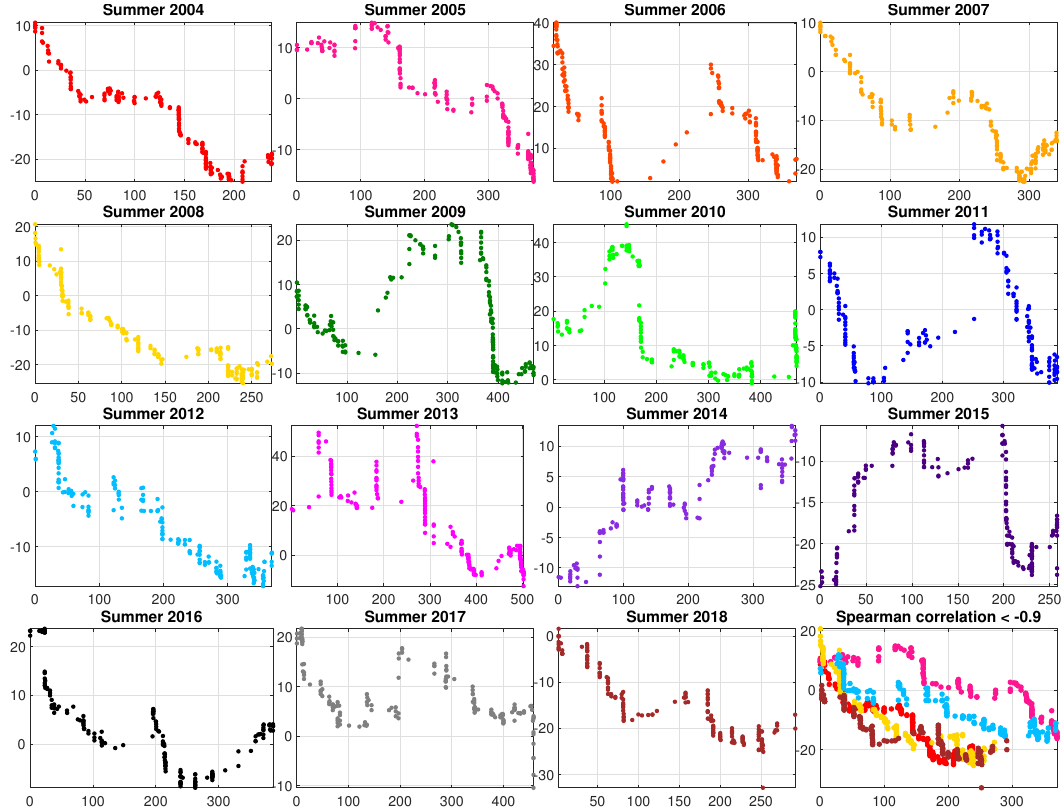
Figure 22. Scatterplots for the summer seasons. On the OY axis, the detrended groundwater levels and on the OX axis the cumulative sums of precipitation are presented. The bottom right plot presents the summer seasons with the highest correlation: 2004, 2005, 2008, 2012,